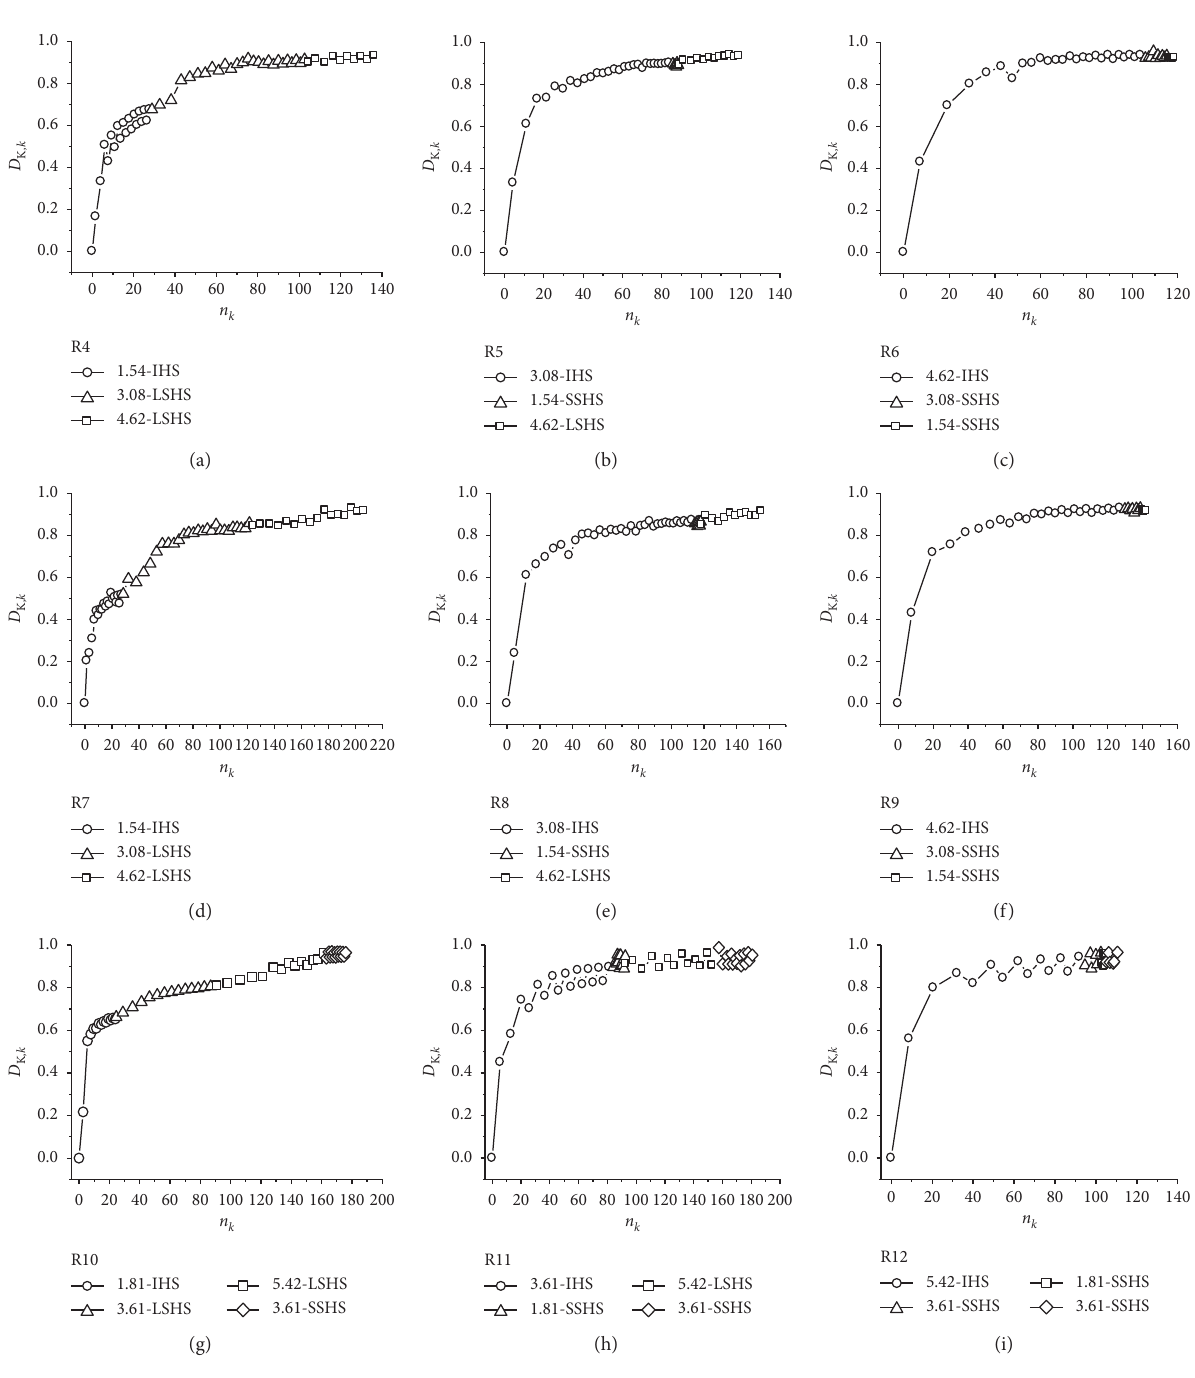
Figure 6: D K, k - n k relations for specimens R4 to R6, R7 to R9, and R10 to